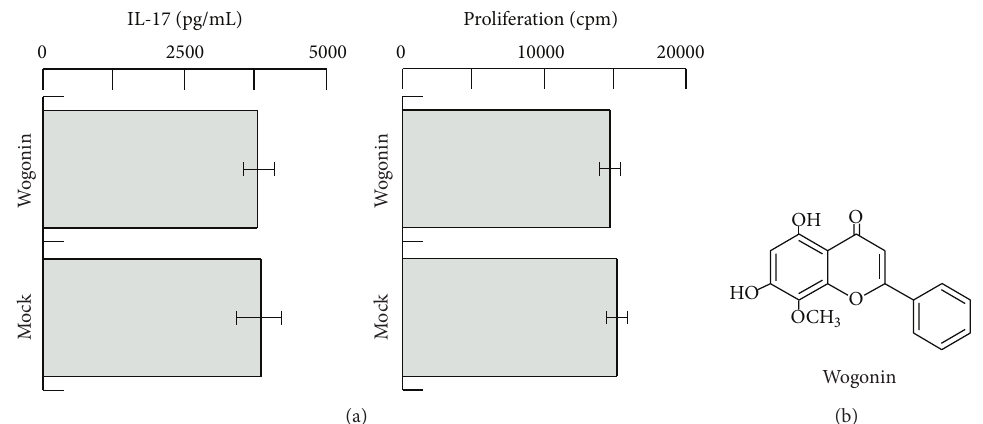
Figure 4: Effects of wogonin on a human Th17 clone. The human alloreactive Th17 clone was established earlier [17]. Following incubation of Th17 with irradiated allogeneic PBMCs in the presence or absence of wogonin (1 𝜇 M) for 24 h, the supernatants were analyzed using ELISA to detect the secretion of IL-17 ((a), left). To assess the proliferation of Th17, the cells were incubated with irradiated allogeneic PBMCs in the presence or absence of wogonin (1 𝜇 M) for 72 h and analyzed using [ 3 H] TdR incorporation during the final 16h period. The incorporated radioactivity was analyzed using liquid scintillation counting after harvesting ((a), right). Wogonin belongs to flavonoid species